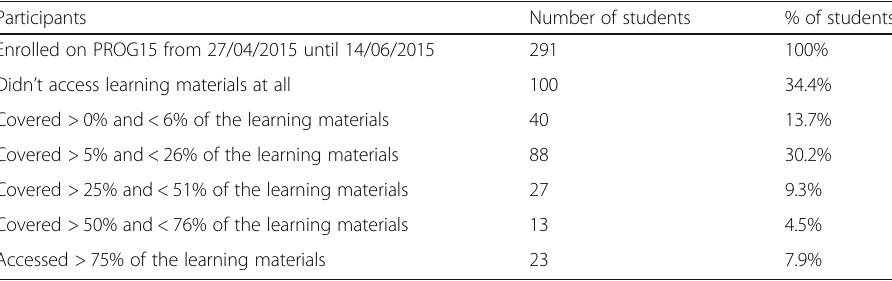
Table 2 Overall PROG15 enrollment, drop-out and completion